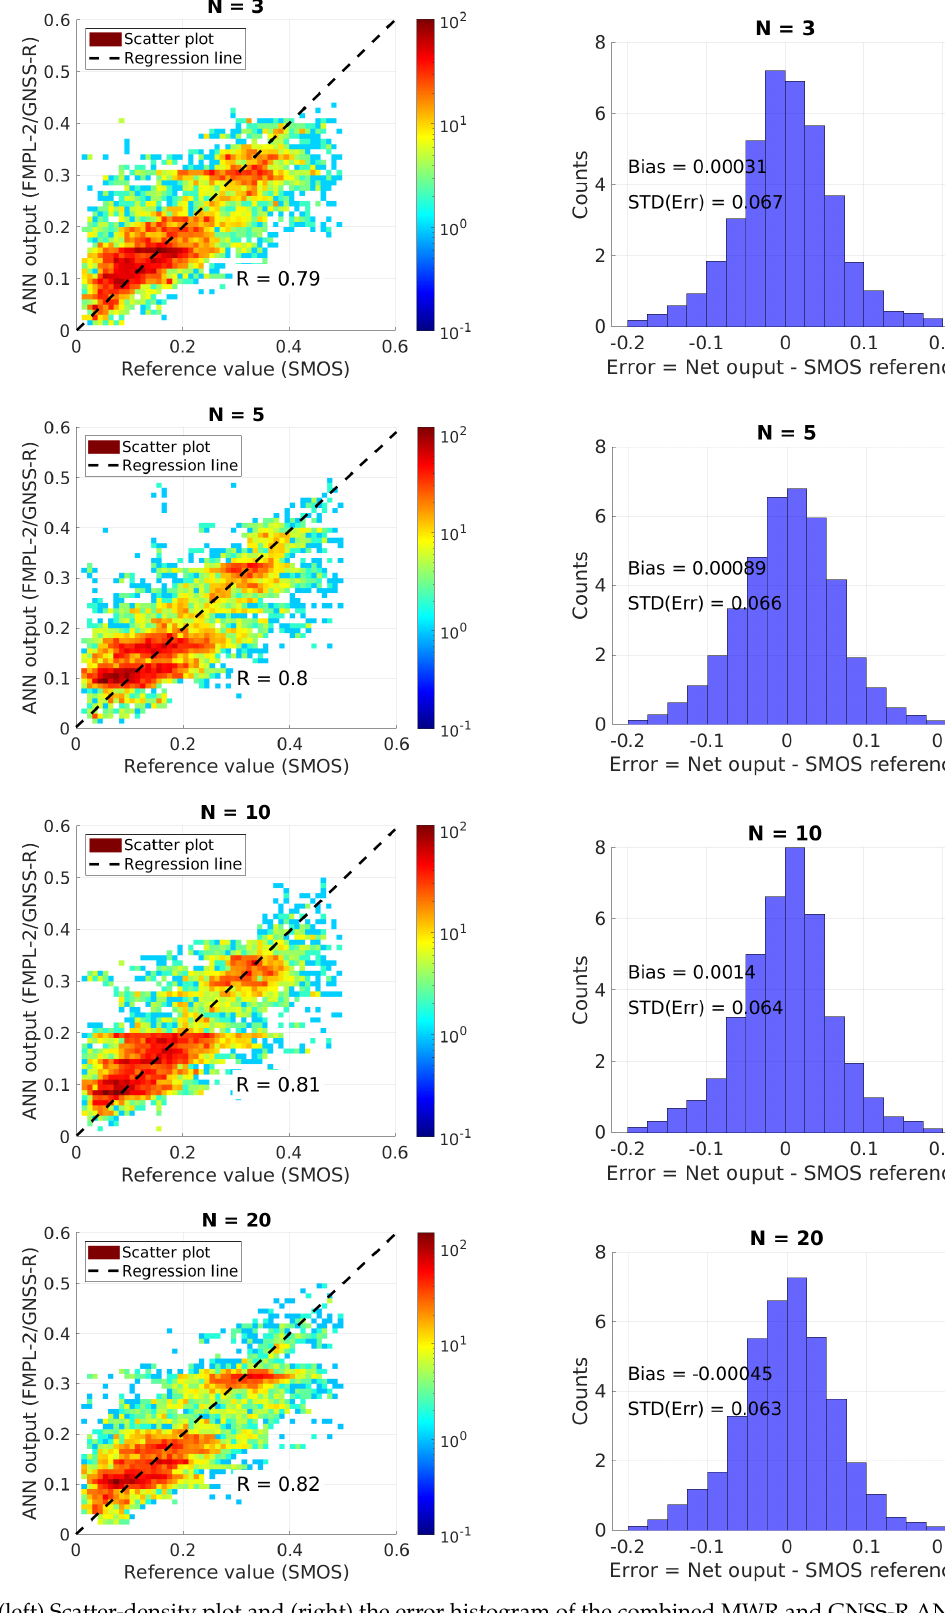
Figure 11. (left) Scatter-density plot and (right) the error histogram of the combined MWR and GNSS-R ANN output with respect to the collocated SMOS SM product from BEC [40], for the four different values of N used to compute movmean and movstd, used as inputs for the